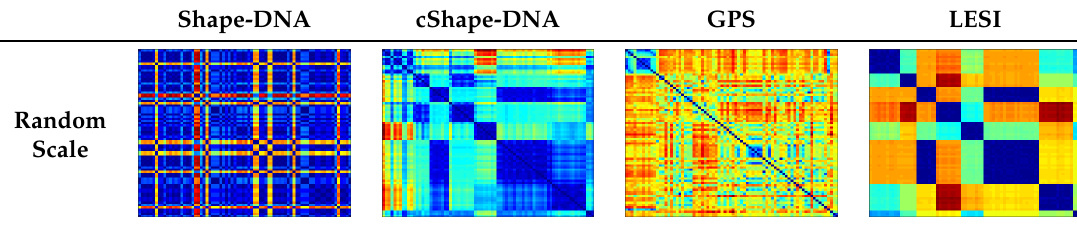
Figure 10. The Euclidean pairwise distance matrix of shape descriptors computed by (from left to right) Shape-DNA, cShape-DNA, GPS, and LESI algorithms over scaled version of the TOSCA dataset by a randomly chosen factor of 0.5, 0.875, 1.25, 1.625, or